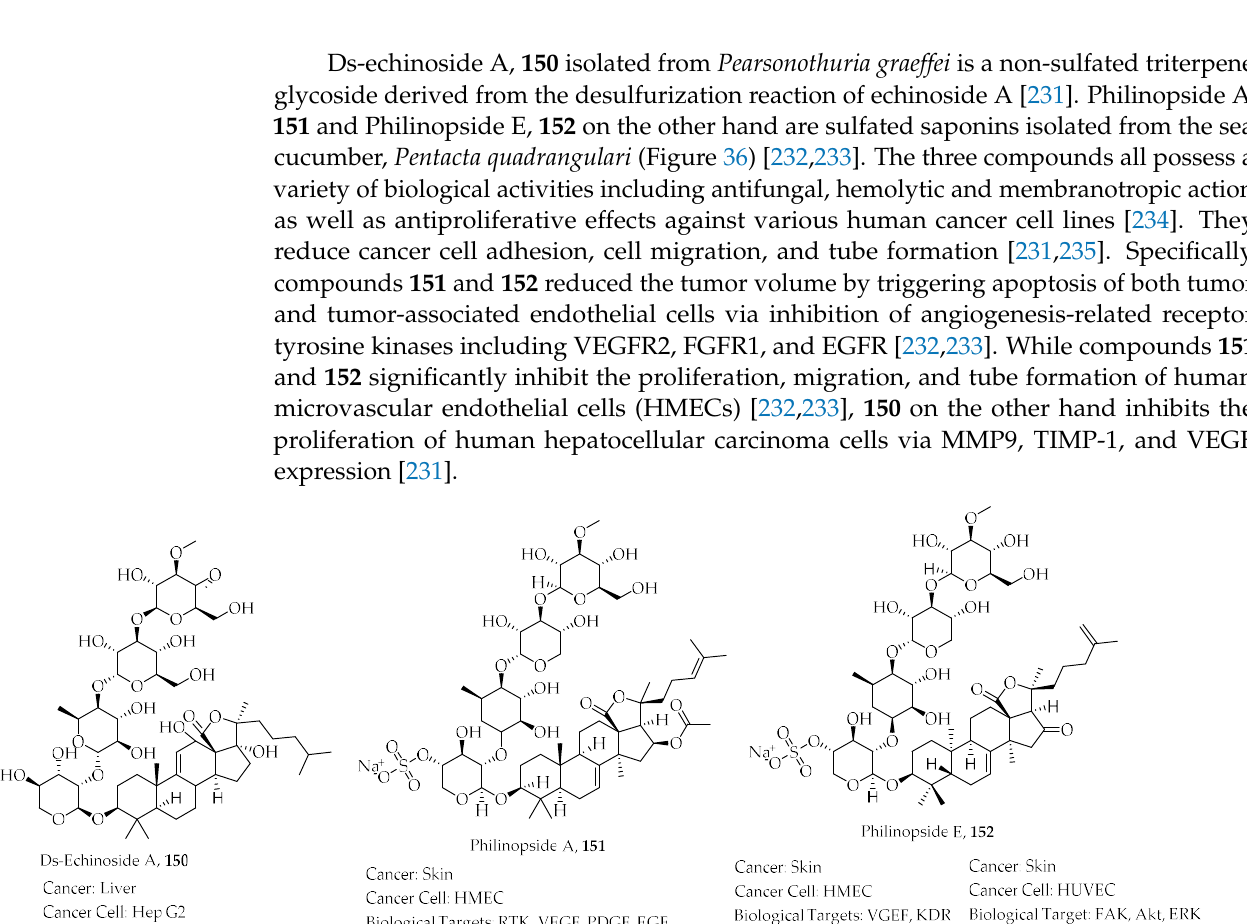
Figure 35. Structures of triterpenoid glycosides Frondaside A and Cucumarioside A2-2 with a sum- mary of their biological activity towards selected cancer targets.